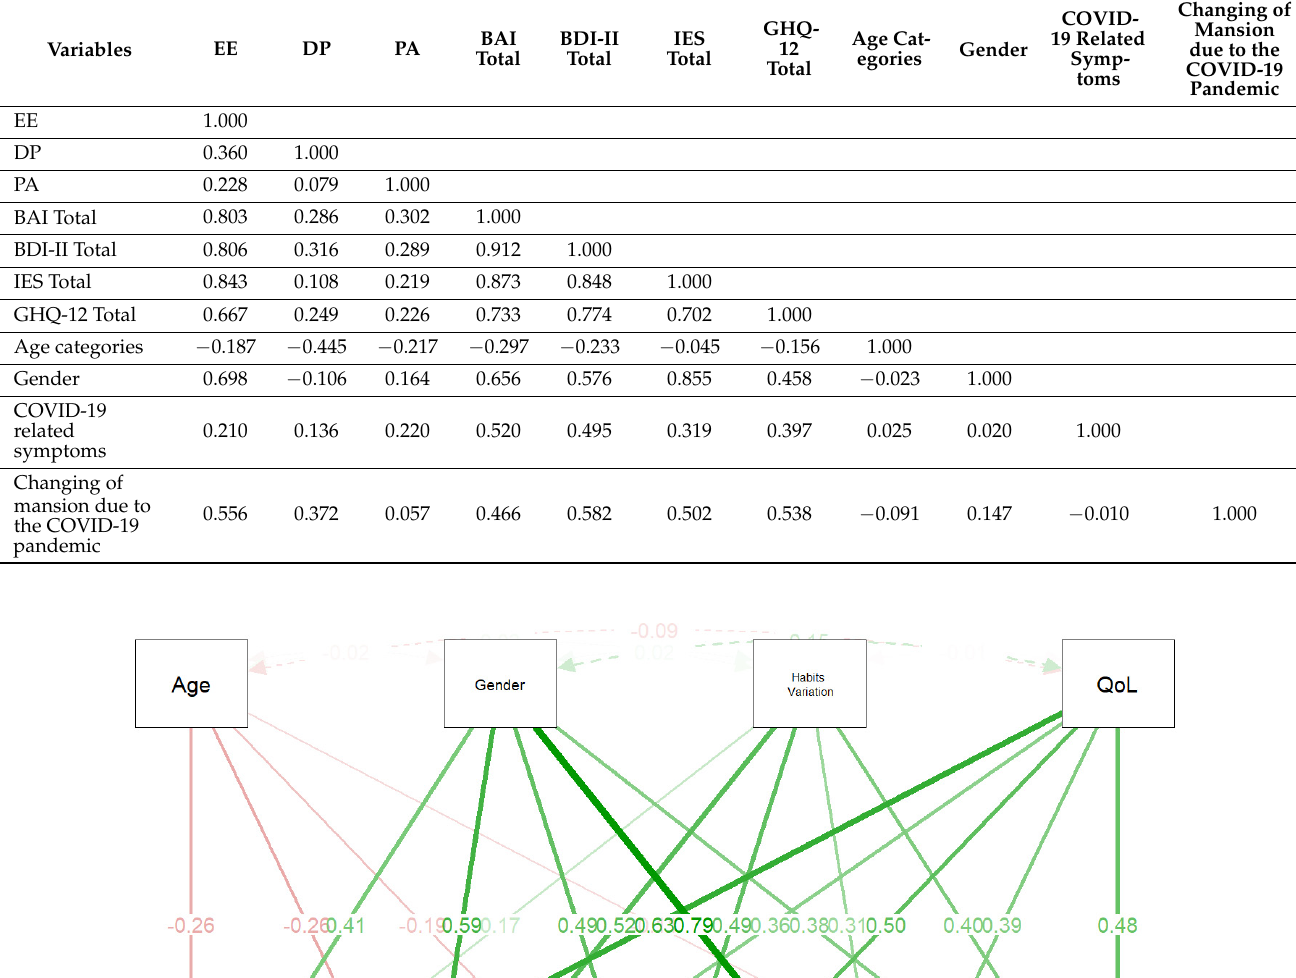
Table 3. Model implied (fitted) among Emotional Exhaustion (EE), Depersonalization (DP), Personal Accomplishment (PA), Beck Depression Inventory (BDI-II), Beck Anxiety Inventory (BAI), Impact of Event Scale (IES) and General Health Questionnaire 12 Items (GHQ-12), Age categories, Gender, COVID-19 related symptoms, Changing of mansion due to the COVID-19 pandemic.